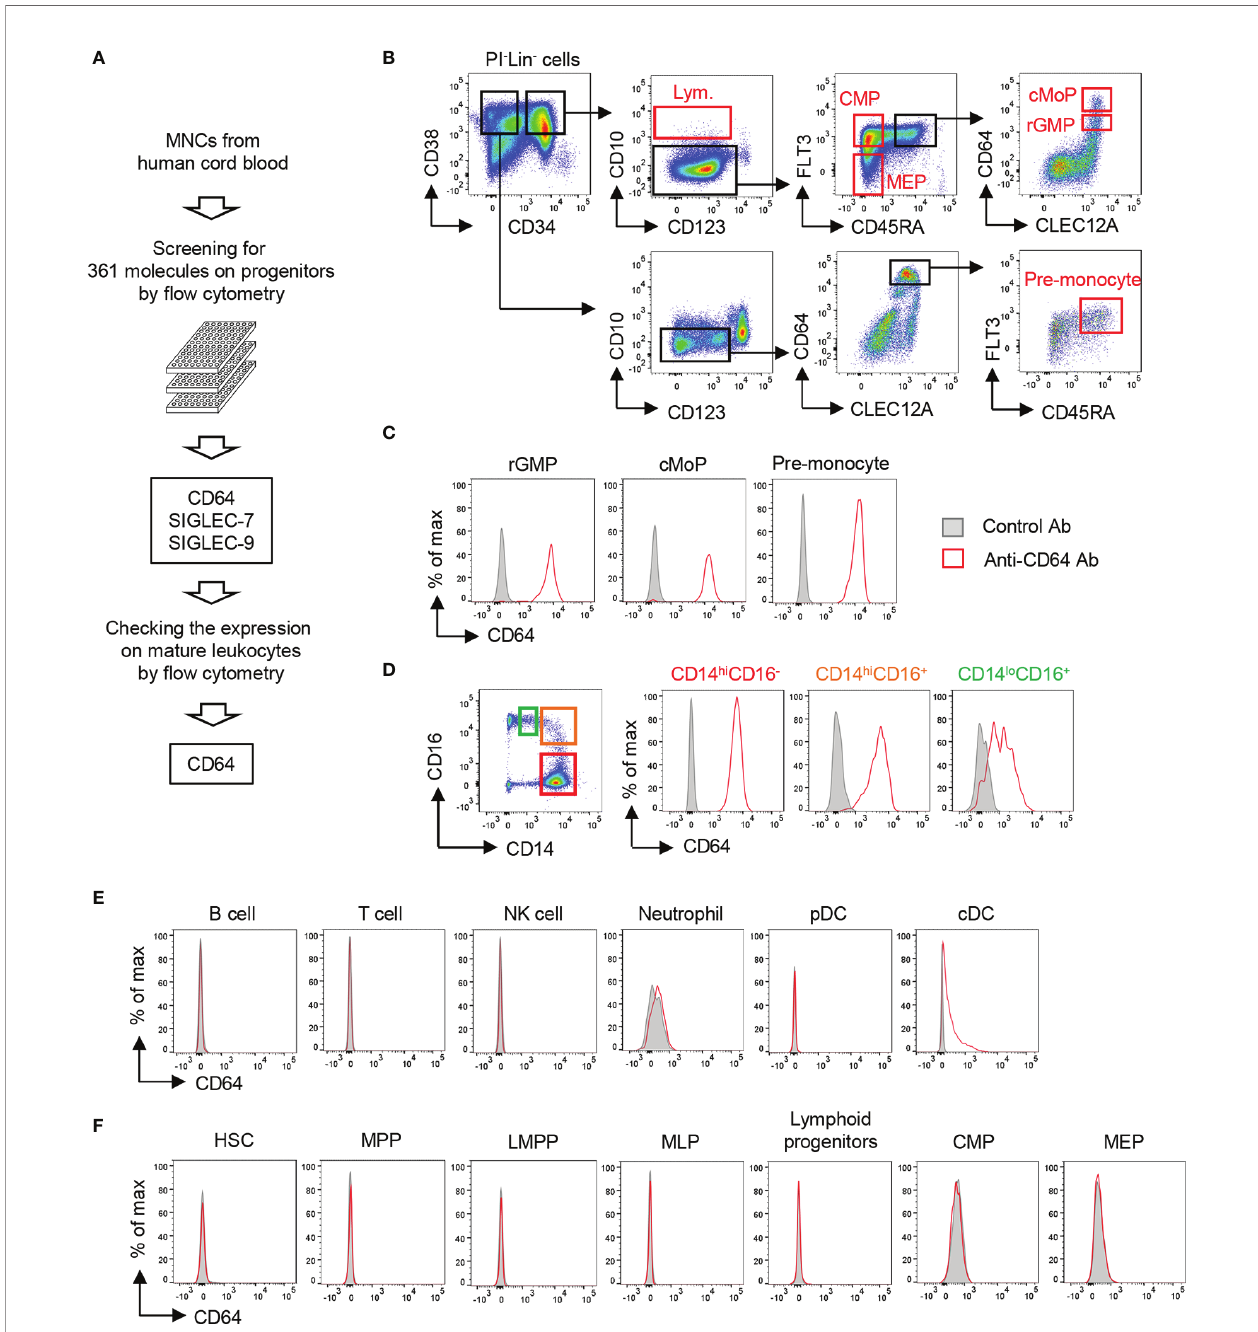
FIGURE 1 | Screening of cell surface molecules to target monocytic progenitors. (A) Screening scheme for molecules highly restricted in monocytic progenitors. The expression of 361 cell surface molecules on HSPCs derived from UCB were examined using FCM. Expression of candidates identi fi ed from HSPC screening was further assessed on mature hematopoietic cell lineages. (B) Gating strategies for hematopoietic progenitors in UCB. Lineage - cells (Lin - cells; CD2 - CD3 - CD11b - CD14 - CD16 - CD19 - CD56 - CD235ab - cells) were pre-gated. Gating strategies of other HSPCs are shown in Supplementary Figure 1A . (C – F) Expression of CD64 on mature hematopoietic cells and their progenitors. CD64 expression was evaluated on monocytic progenitors (C) , monocytes (D) , non-monocytic immune cells (E) and the other hematopoietic stem and progenitor cells (F) by FCM. Each population was identi fi ed by the following gating strategies: B cell, FSC lo SSC lo CD3 - CD56 - CD19 + ; T cell, FSC lo SSC lo CD3 + ; NK cell, FSC lo SSC lo CD56 + CD3 - ; Neutrophil, SSC hi HLA-DR - CD66b + CD16 + ; pDC, CD3 - CD14 - CD19 - CD56 - CD11c - HLA- DR + CD123 + ; cDC, CD3 - CD14 - CD19 - CD56 - CD123 - HLA-DR + CD11c + . Blood monocytes (HLA-DR + CD14 + ) were subdivided into three populations based on their expression of CD14 and CD16 as shown in ( D , left panel). The data are representative of three independent